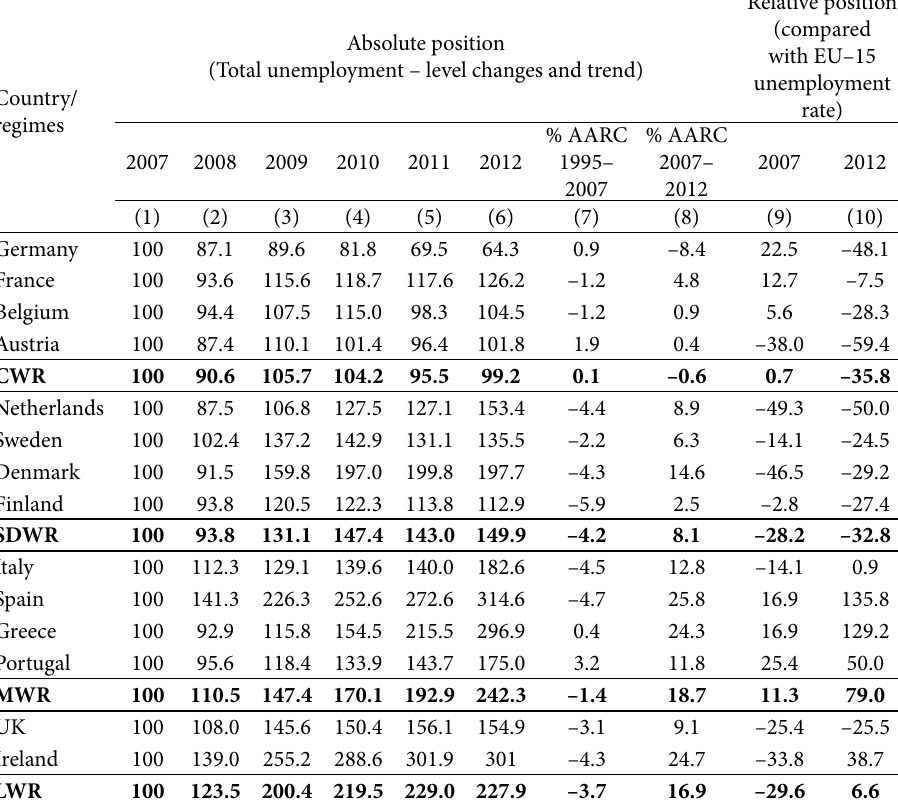
Table 2. The impact of the crisis on unemployment in the EU–15